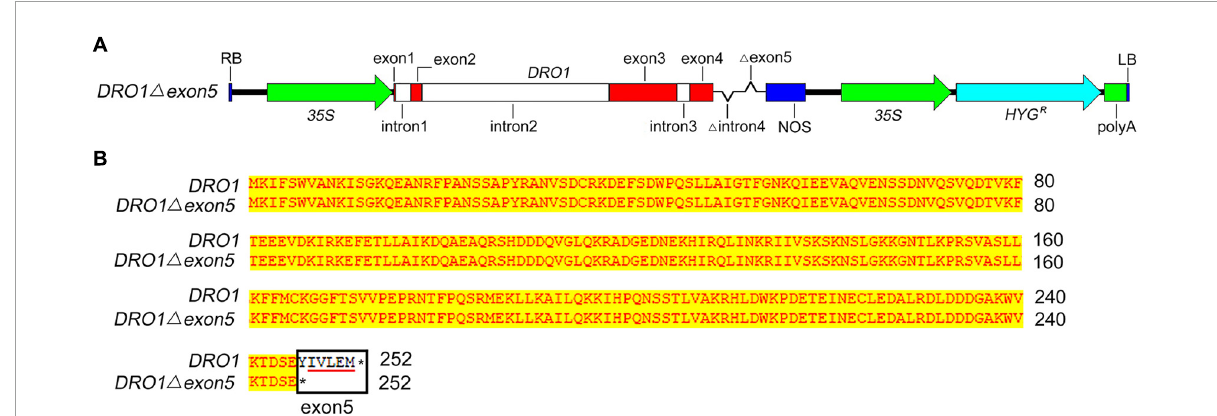
FIGURE5 Construction of expression vector containing the DRO1 gene. Schematic diagram of the expression vector containing DRO1 deleted the fourth intron and the fifth exon (A) . The alignment of amino acid sequences of native DRO1 and the DRO1 containing a deletion of the fifth exon sequence expressing in transgenic Acuce rice lines (B) . The red boxes indicate exons and white boxes are introns. The black rectangle indicates the fifth exon of DRO1 , the red line indicates the EAR-like motif in the DRO1 sequences. 35S, 35S promoter; NOS, nopaline synthase terminator; HYG, hygromycin resistance gene; polyA, polyadenylate; asterisk, protein translation